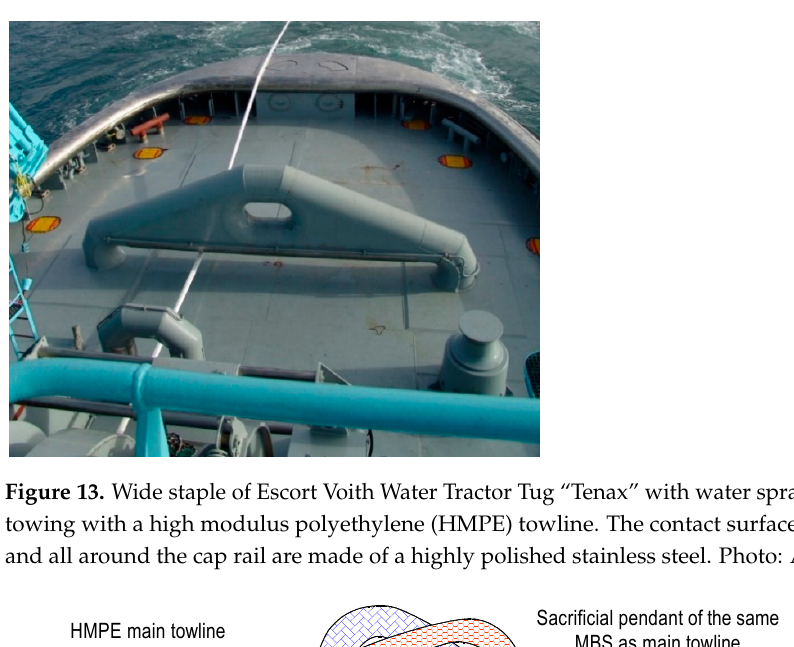
Figure 13. Wide staple of Escort Voith Water Tractor Tug “Tenax” with water spray cooling for escort towing with a high modulus polyethylene (HMPE) towline. The contact surfaces of both the staple and all around the cap rail are made of a highly polished stainless steel. Photo: Authors.